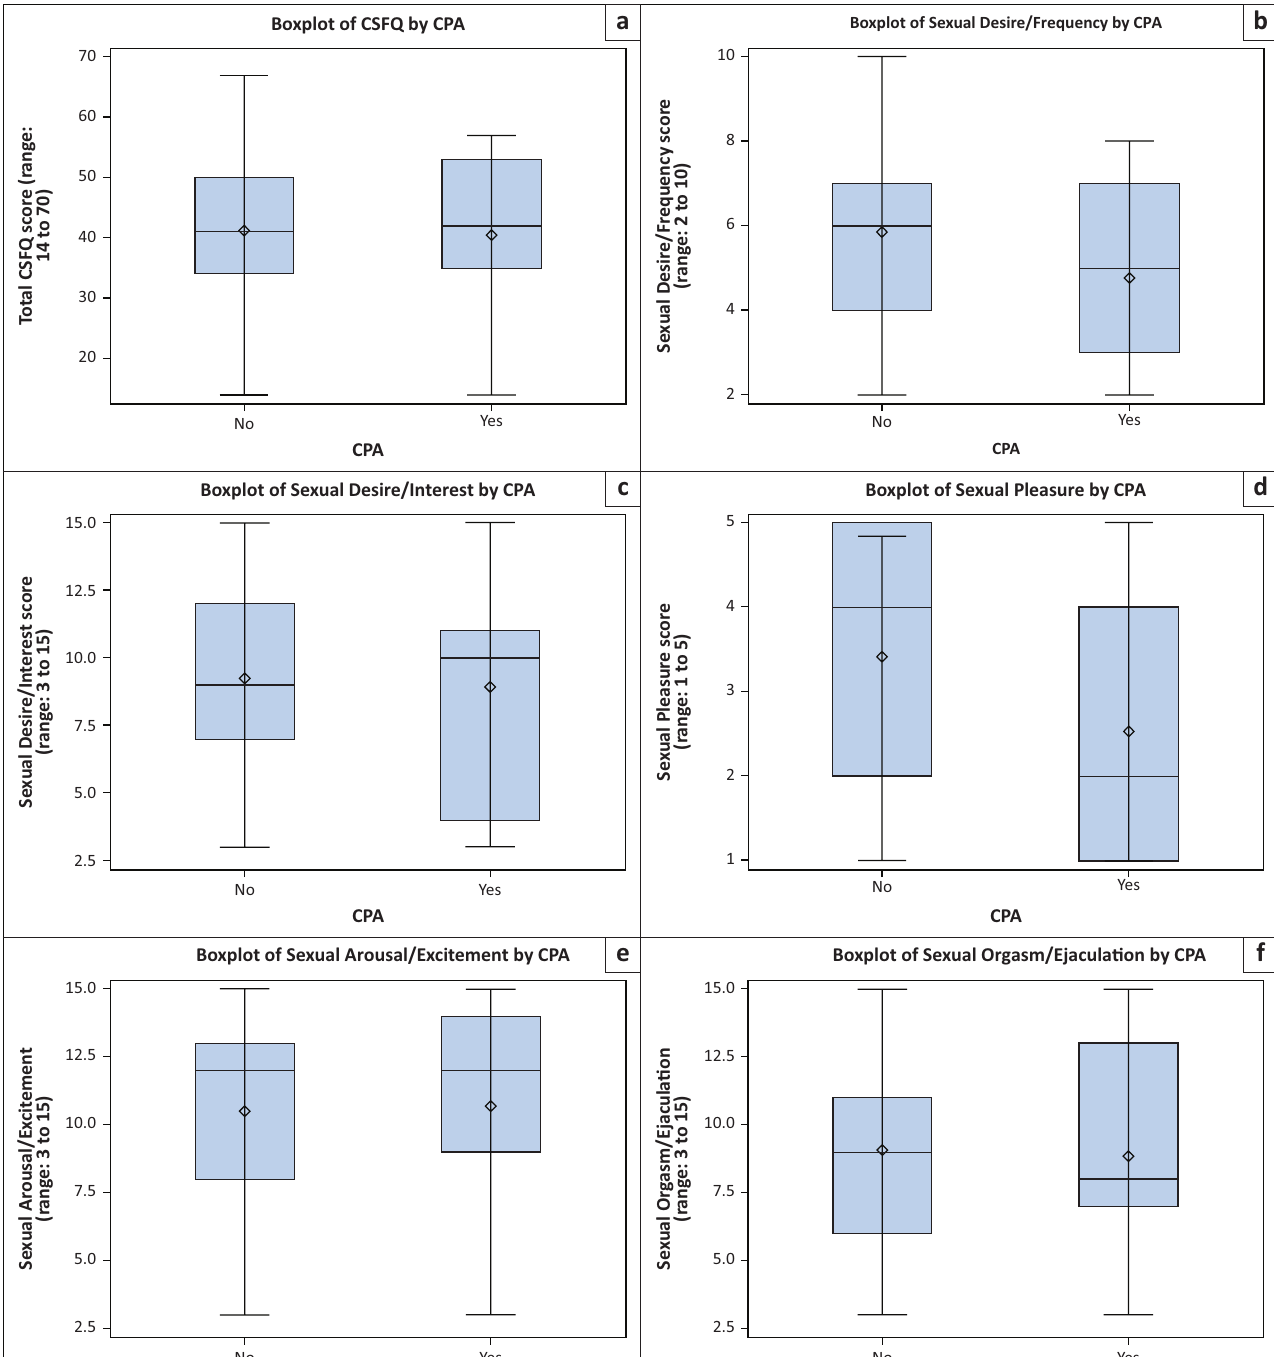
f Boxplot of Sexual Arousal/Excitement by CPA Boxplot of Sexual Orgasm/Ejacula(cid:31)on by CPA